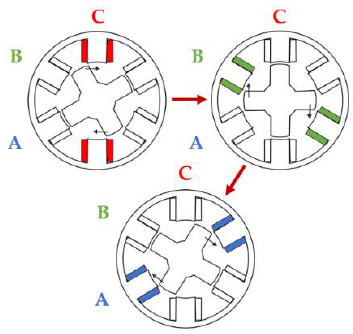
Figure 2. SRM operation principle.